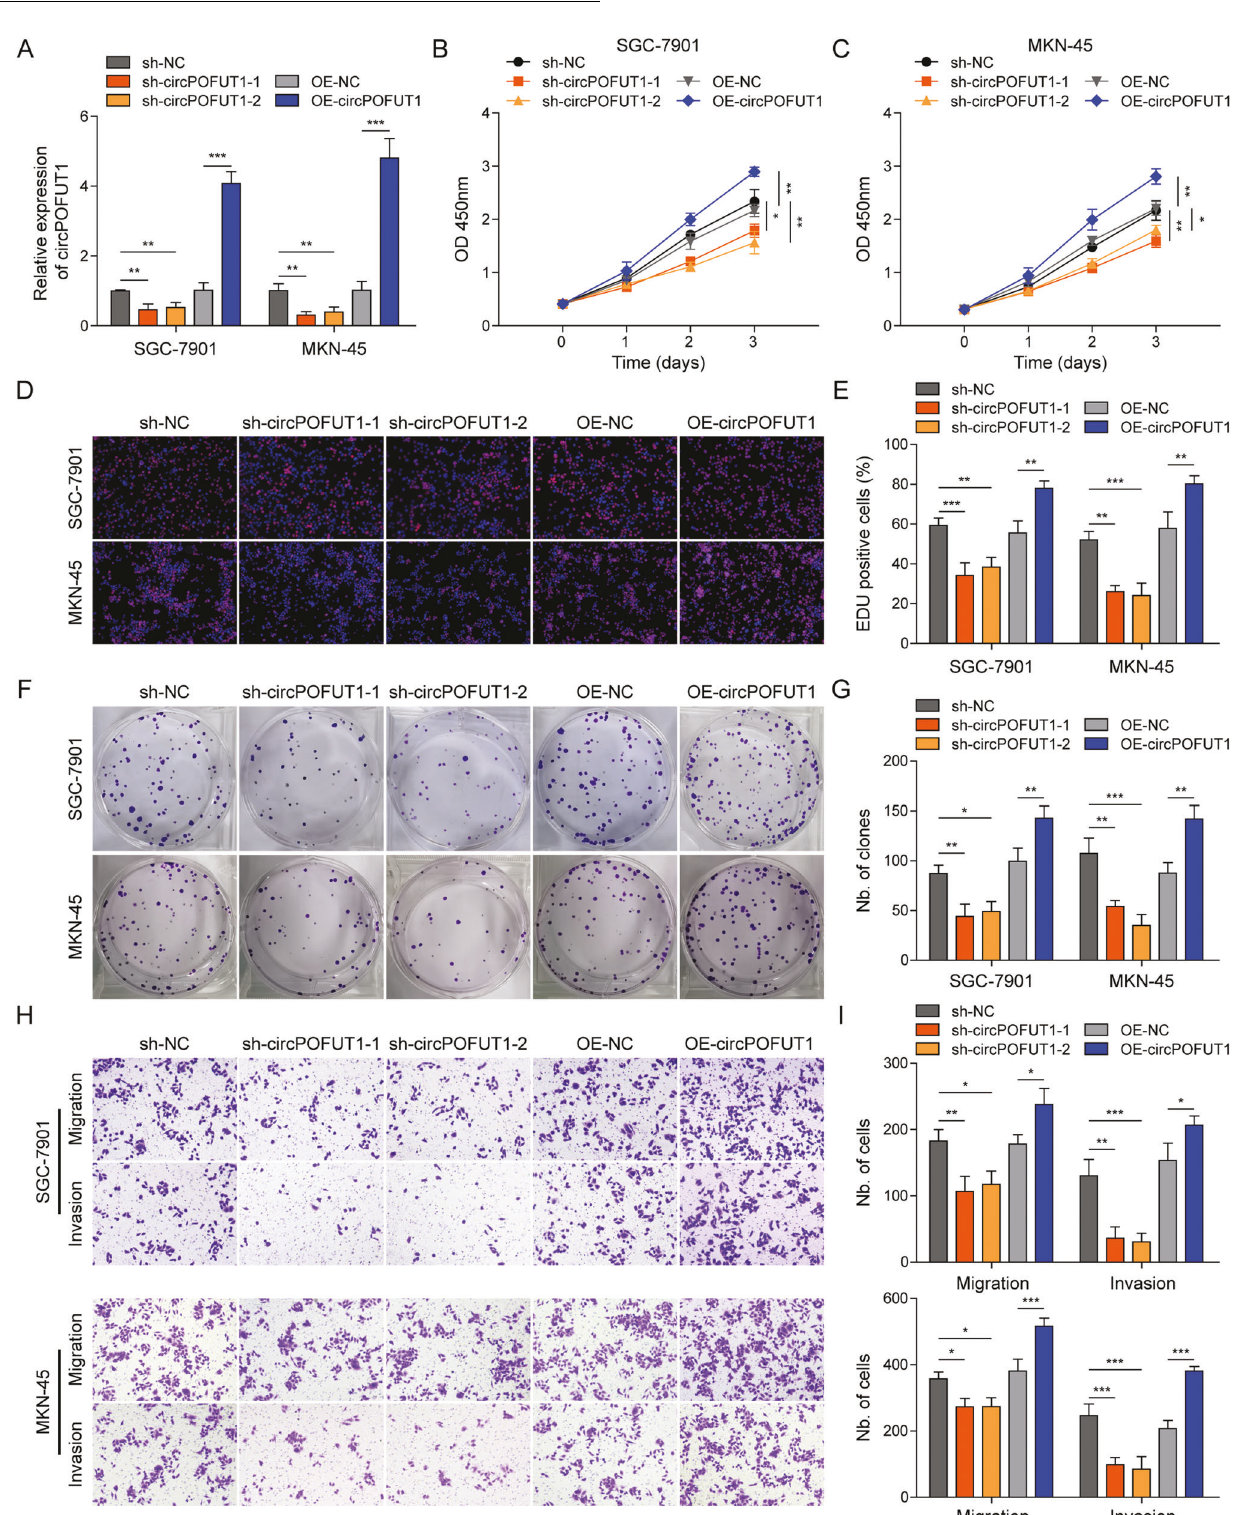
Fig. 3 CircPOFUT1 promoted GC cell proliferation, migration and invasion. A RT-qPCR analysis of circPOFUT1 ( n = 3). B , C Cell proliferation was analyzed by CCK-8 ( n = 3). D , E EdU (Red) incorporation assays ( n = 3; Nuclei, Blue). F , G Colony-forming capacity of GC cells ( n = 3). H , I Transwell assays for migration and invasion ( n = 3). * P < 0.05, ** P < 0.01 and *** P <